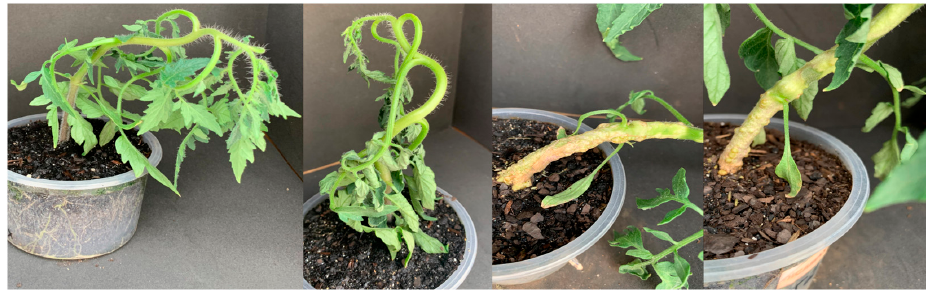
Figure 3. Symptoms evolution in tomato plants due to simulated dicamba drift at dose ratios 1/16D, 1/32D, and 1/64D (45, 22.5, and 11.25 g a.e. ha − 1 , respectively) of the recommended dose (D). Evaluations were made from 1 to 7, 14, and 21 days after application (DAA). Front view ( A ) and top view ( B ) of tomato plants a ff ected by simulated drift.